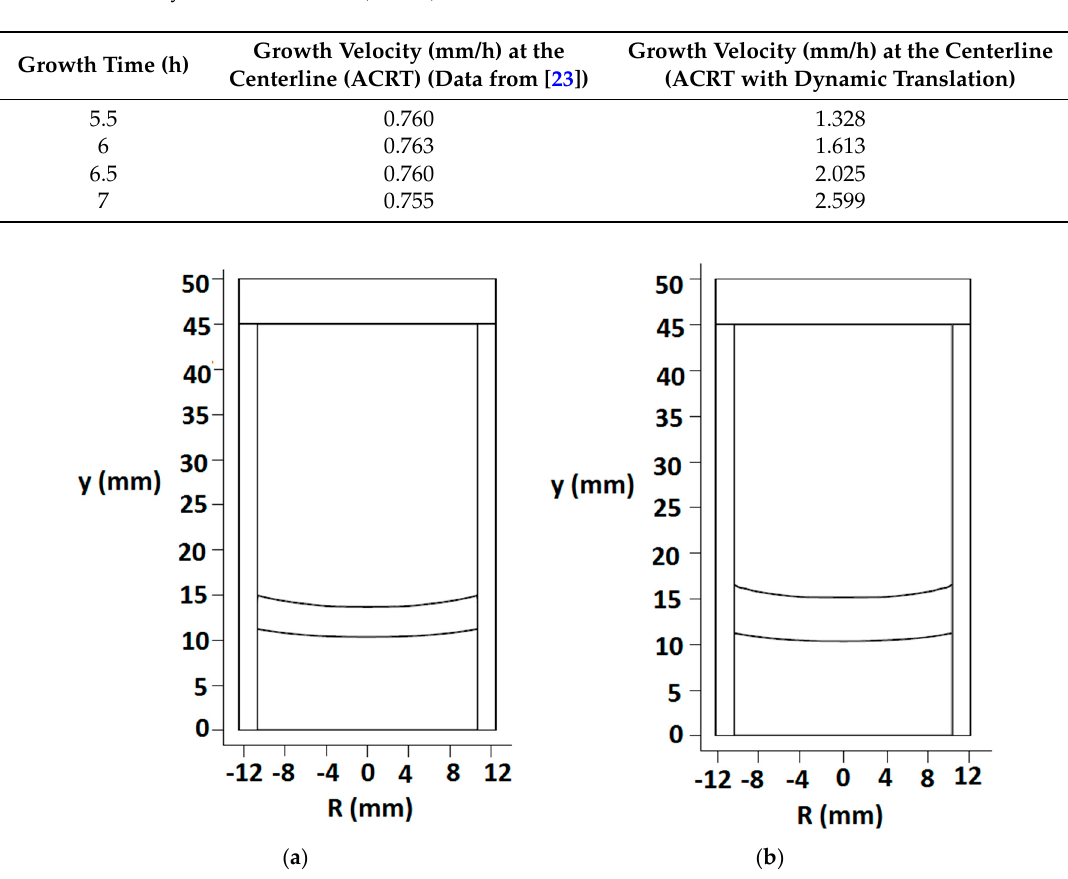
Table 1. Variation of the time averaged growth velocity at the centerline with growth time after the initiation of dynamic translation (t = 5 h).